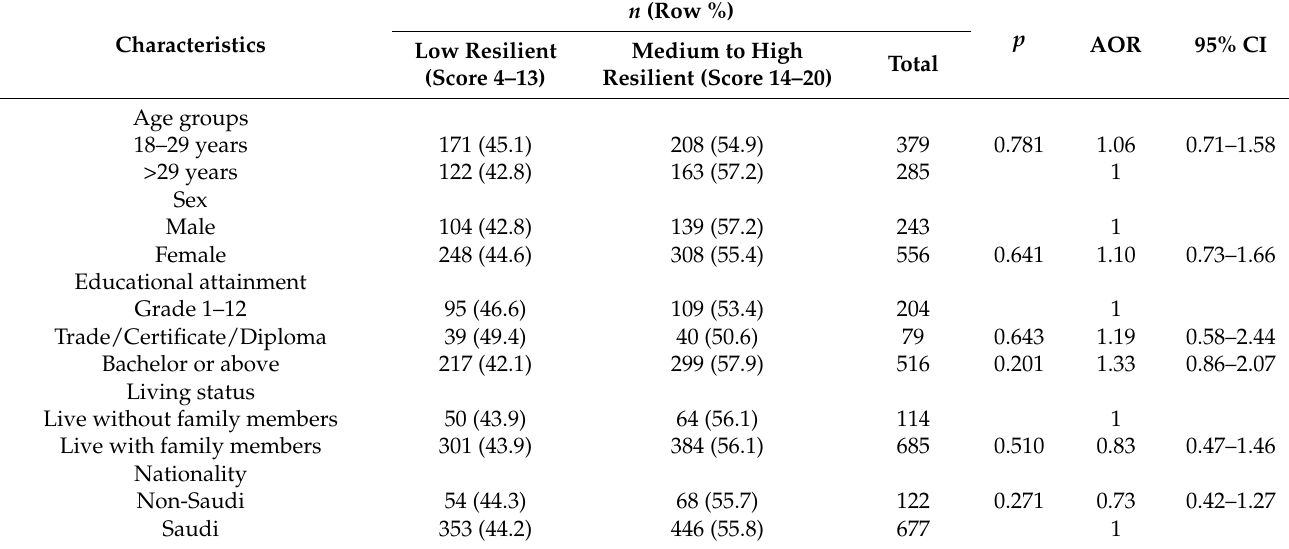
Table 7. Factors associated with coping with the COVID-19 pandemic in Saudi